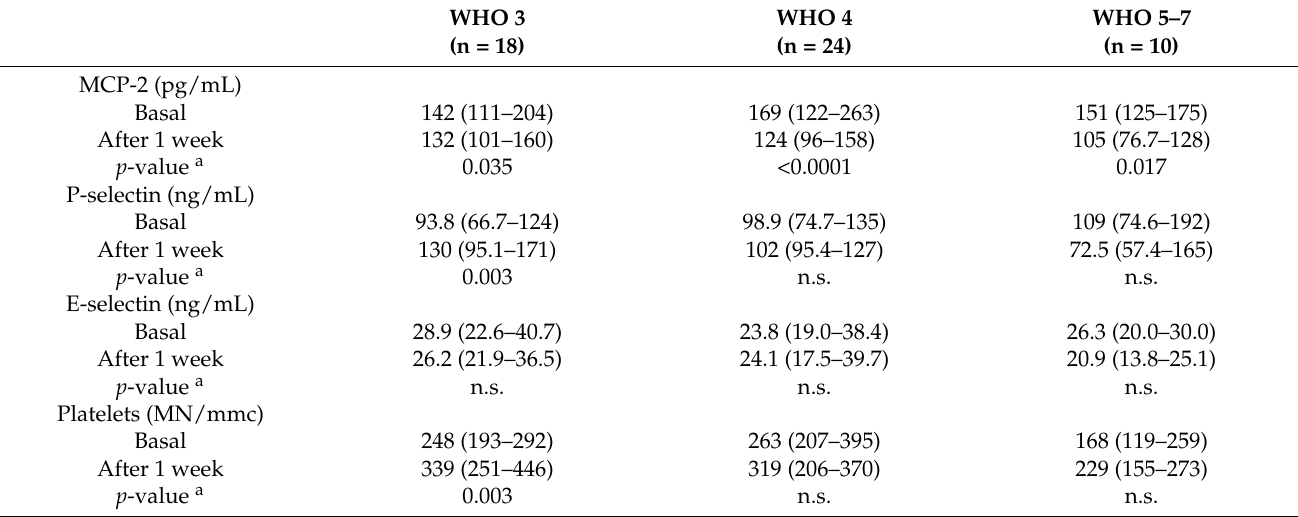
Table 2. Comparison of serum MCP-2, selectins, and platelet number in COVID-19 patients at hospital admission and after 1 week.